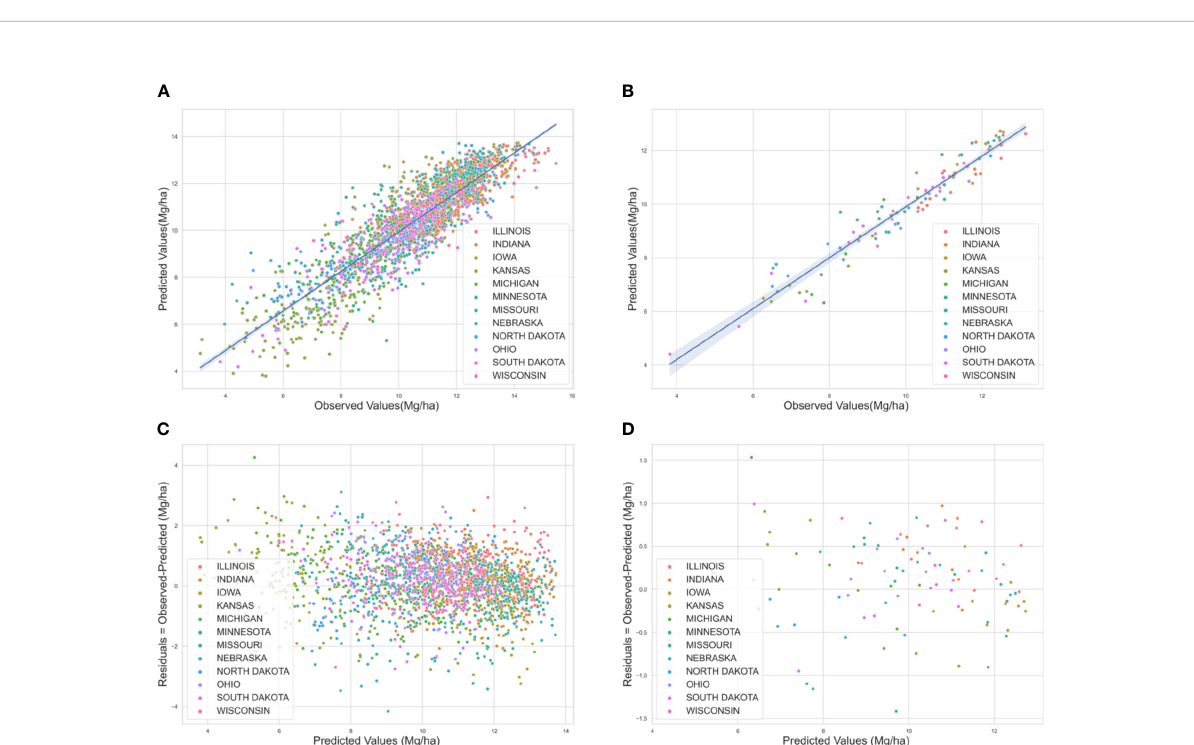
FIGURE 3 (A) Predicted versus observed yield for the U.S Corn Belt for the years 2018-2020 at the county level. The straight lines at 45 0 show a strong correlation between the predicted and observed yield (B) at the crop reporting district level. (C) Residual plot for the U.S Corn Belt for the years 2018-2020 at the county level (D) residual plot at the crop reporting district level. The errors are scattered around zero lines, indicating an unbiased model. Each color corresponds to a particular